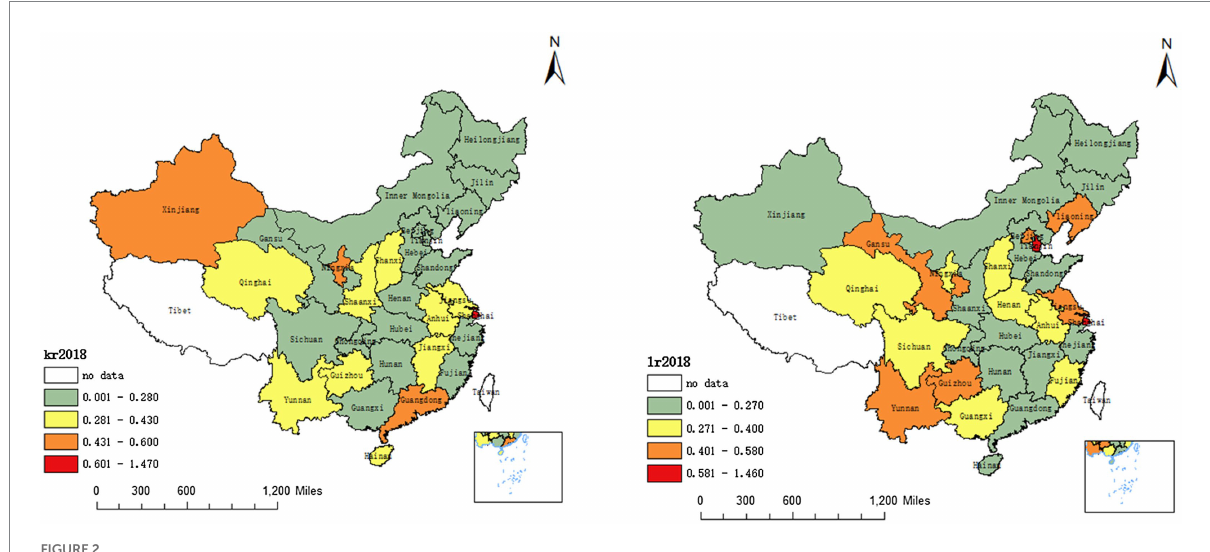
FIGURE 2 China’s capital misallocation and labour misallocation in the year